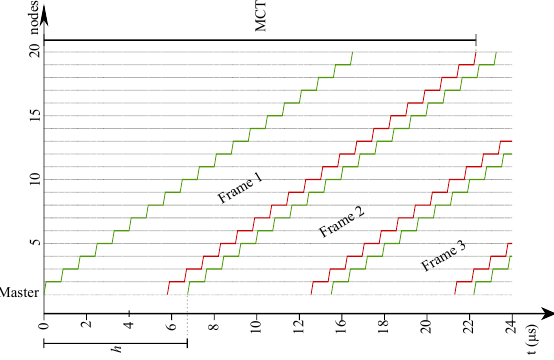
Figure 2. Ethernet frames traveling in a network. The green and red lines indicate the start and end of a frame,